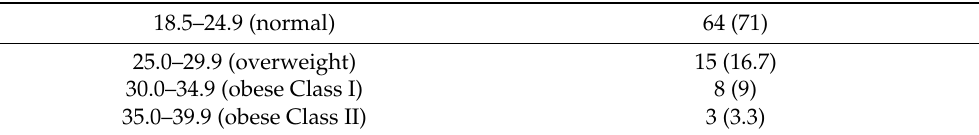
Table 11. BMI of patients who performed regular